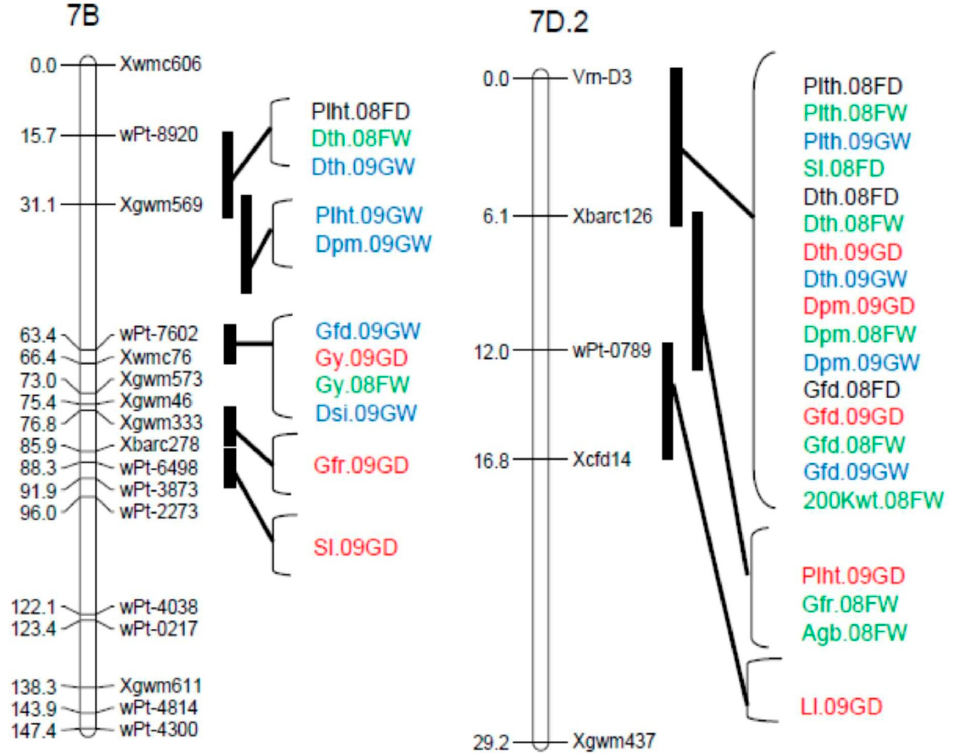
Figure 1. Prominent QTL clusters detected for agronomic traits of the CO940610/Platte population